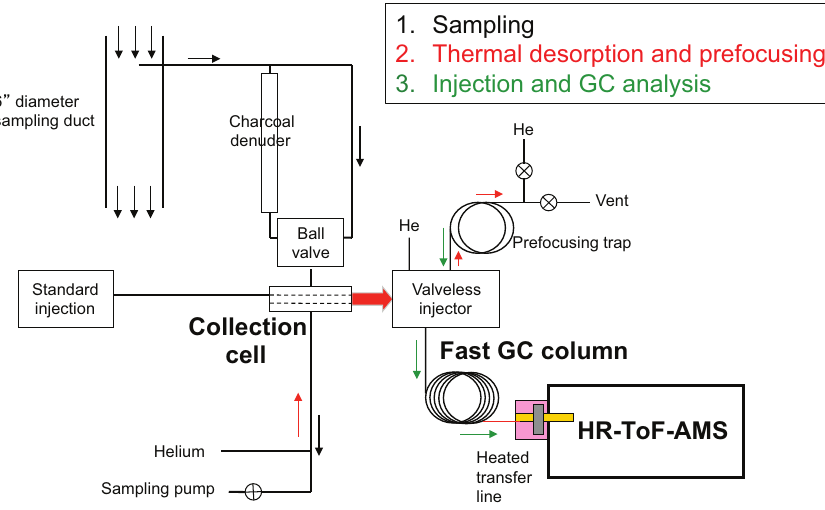
Figure 1. A schematic of the SV-TAG sample introduction system into the HR-ToF-AMS. The arrows in black, red, and green denote the flow paths during sample collection, thermal desorption and prefocusing, and injection into GC/MS analysis,